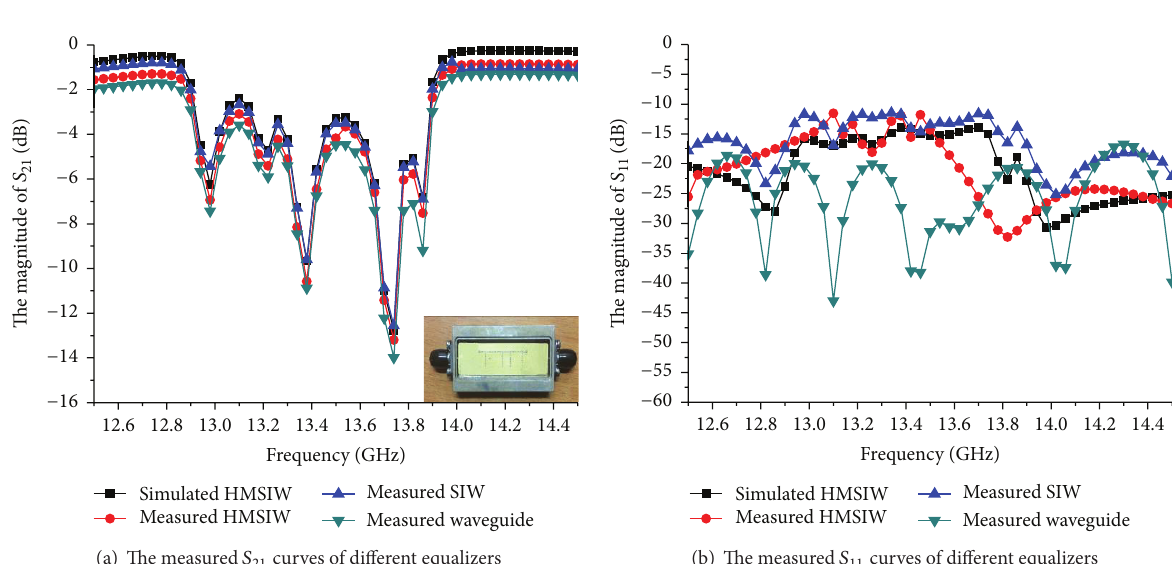
Figure 6: Method proposed in this paper: simulation and measurement